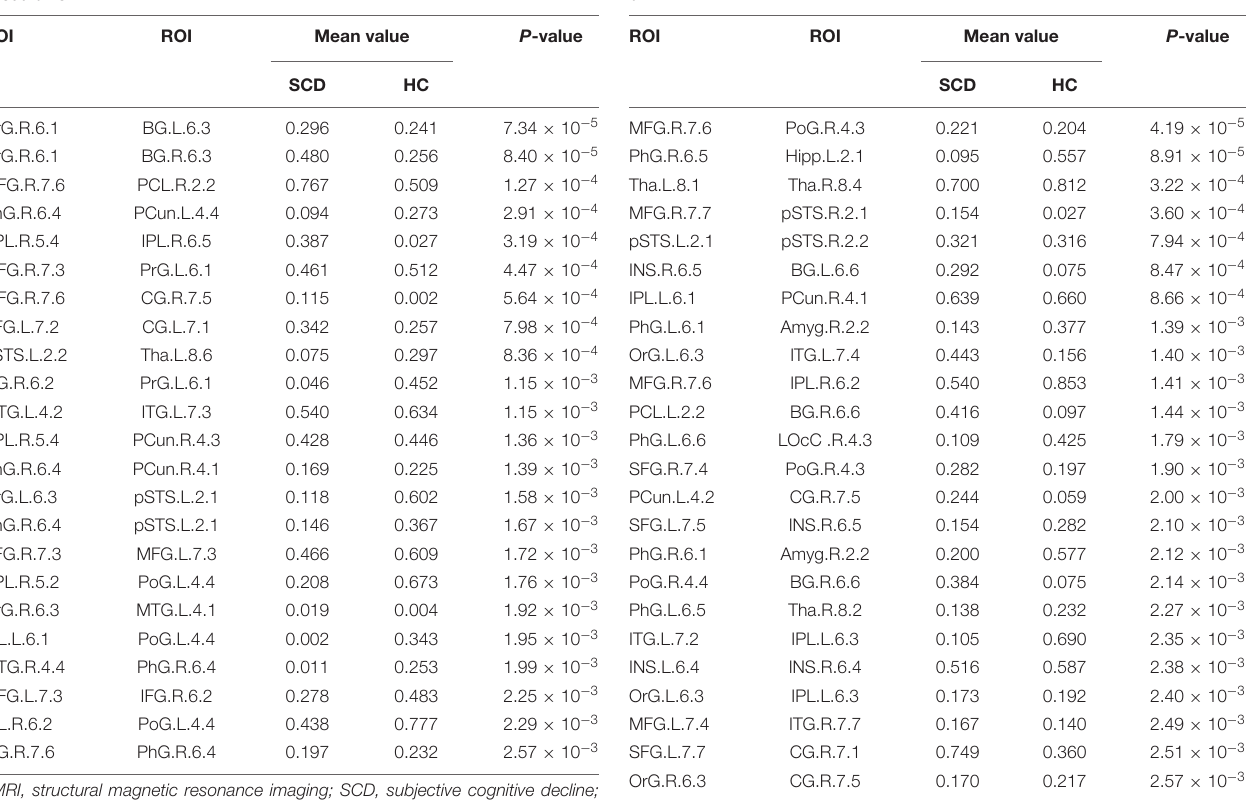
TABLE 7 | Consensus connections identified by functional brain network based on